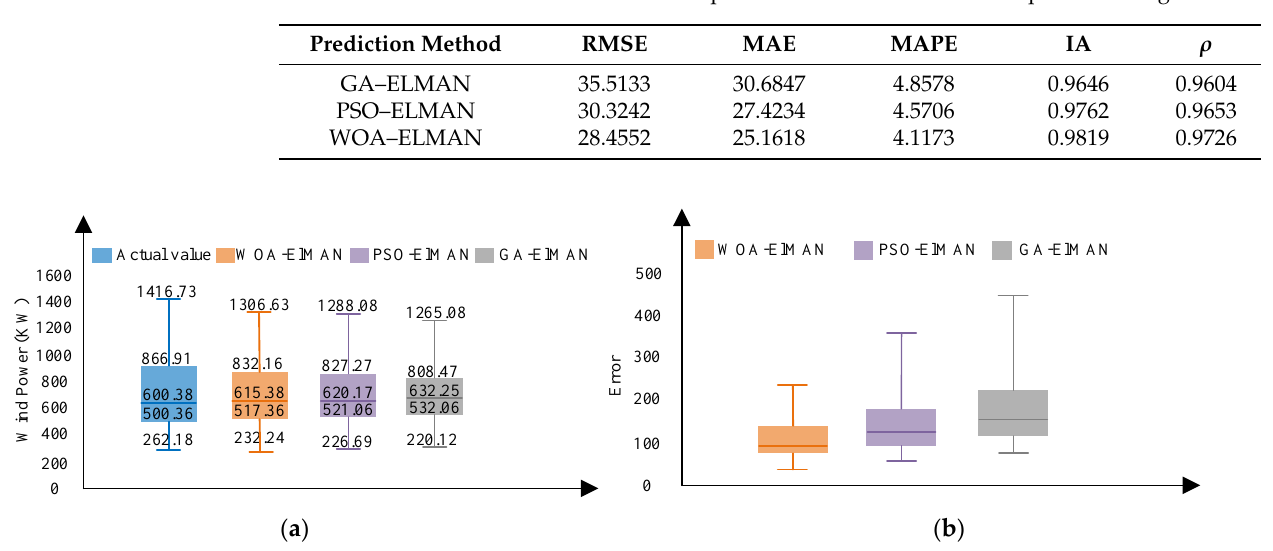
than GA and PSO. Table 1. Error evaluation index value of each prediction model under various optimisation algo- rithms.